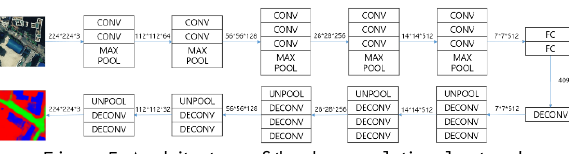
Figure 5. Architecture of the deconvolutional